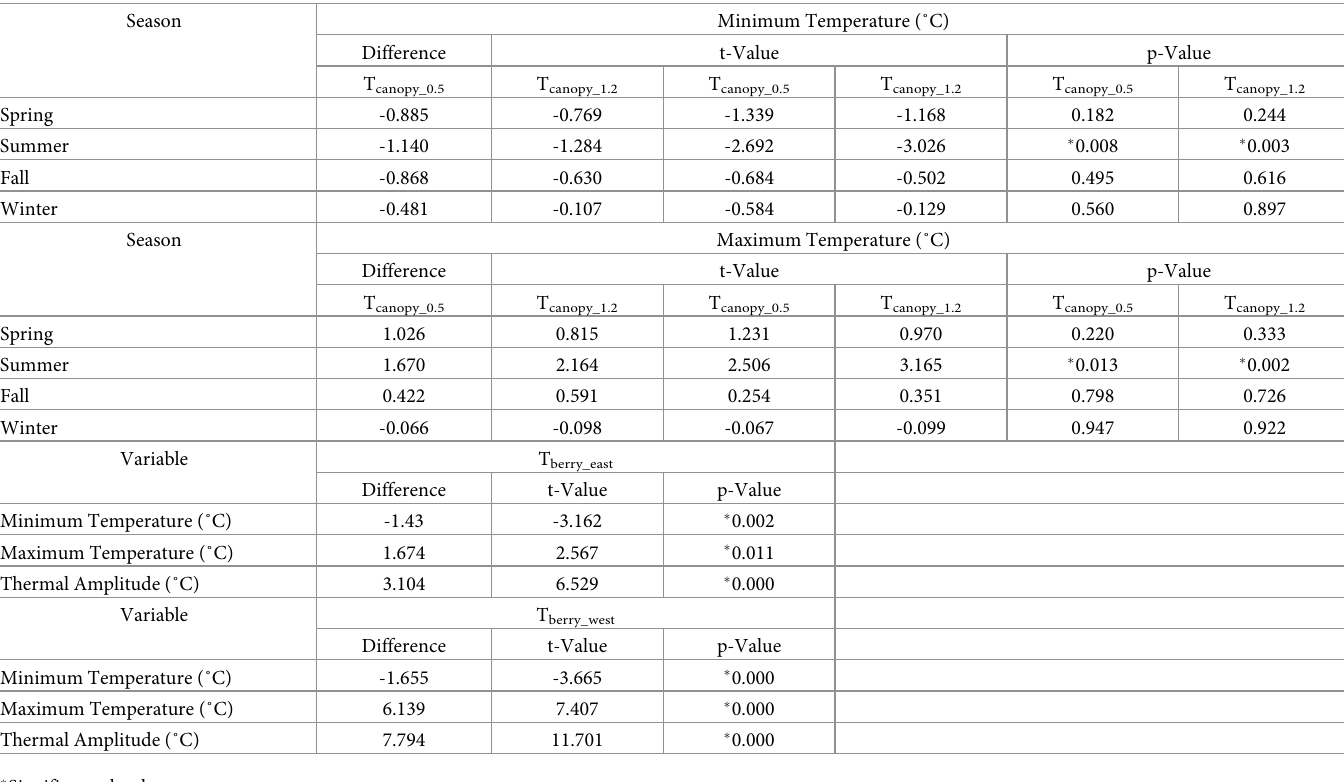
Table 2. T-test comparison between the daily air temperature measured under standard conditions (T station_1.7 ) and within the canopy. a. Comparison between T sta- tion_1.7 and air temperature within the canopy at a height of 0.5 (T canopy_0.5 ) and 1.2 m (T canopy_1.2 ) above the soil surface based on seasonal differences. The air temperature was recorded between December 2015 and June 2017. b. Comparison between the daily air temperature measured under standard conditions (T station_1.7 ) and among the berries in the clusters facing east (T berry_east ) and west (T berry_west ). The temperature was recorded between December 2015 and June